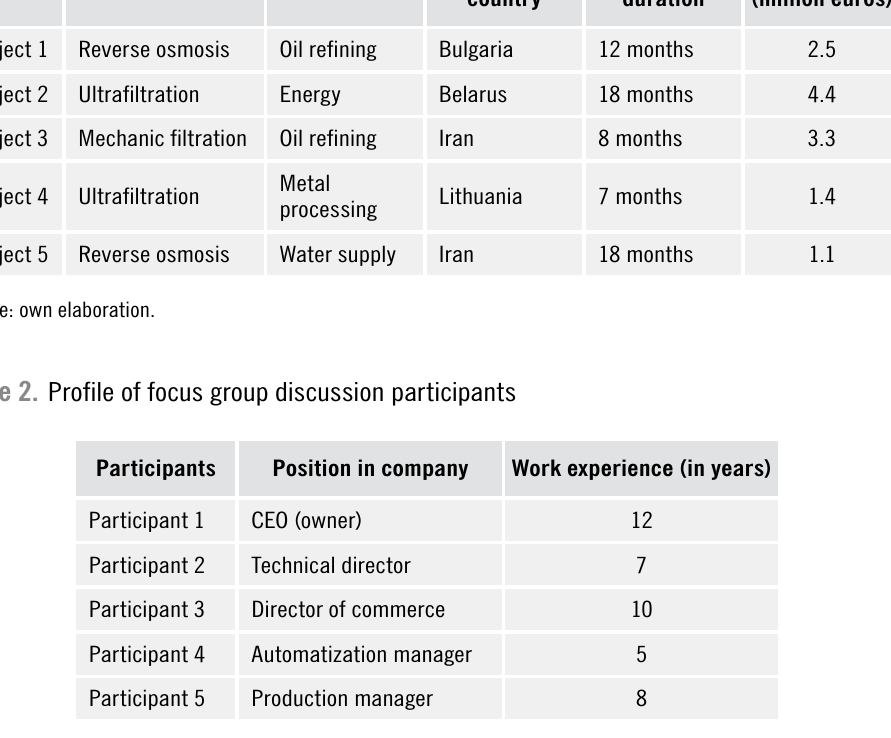
Table 1. List of studied engineering service innovation projects Project